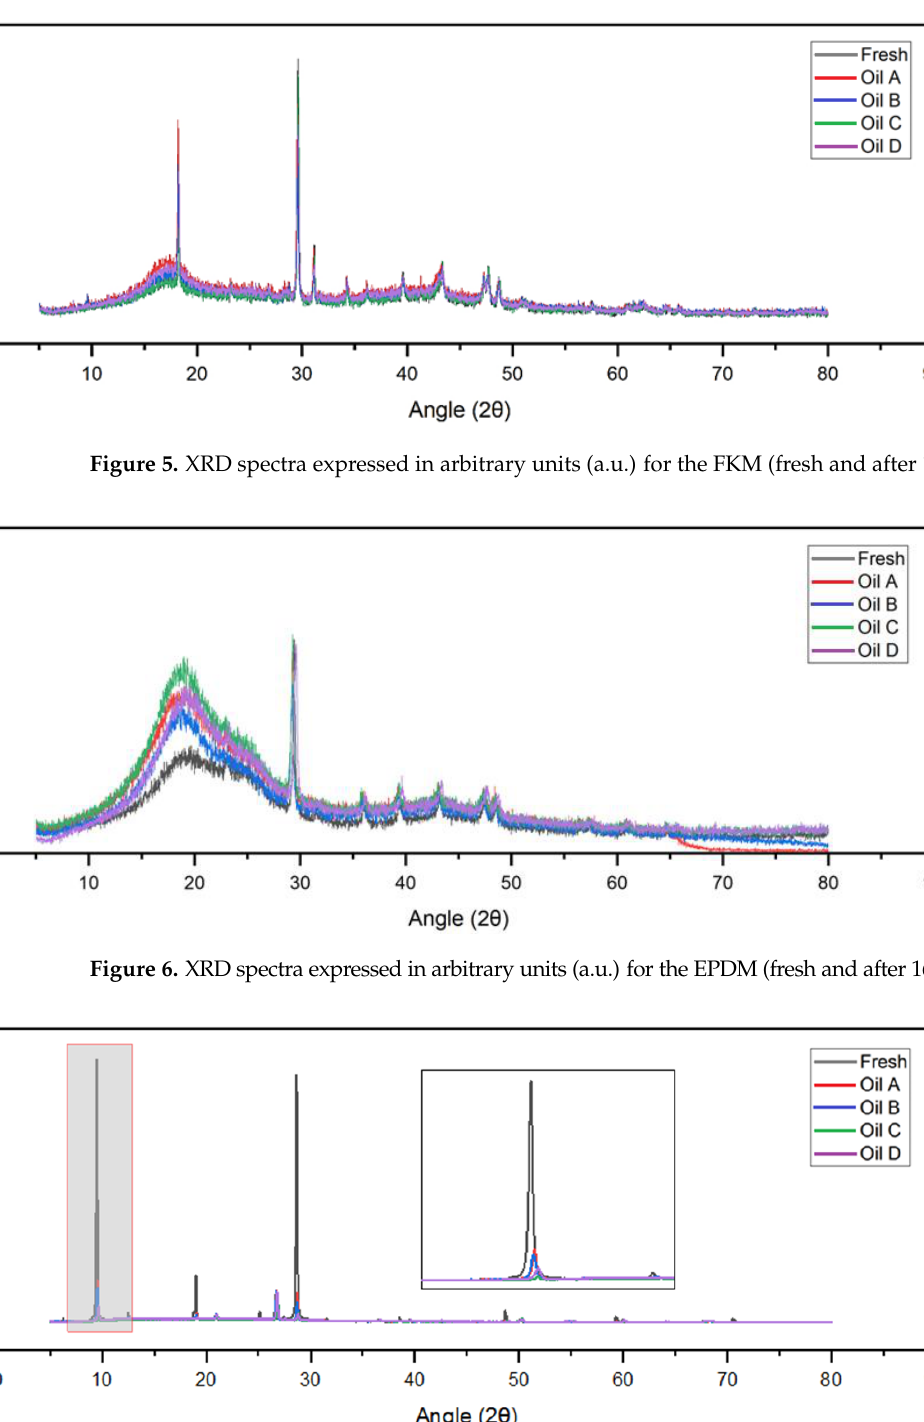
Table 5. Crystallinity percentage of the FKM samples for different aging times. ATF